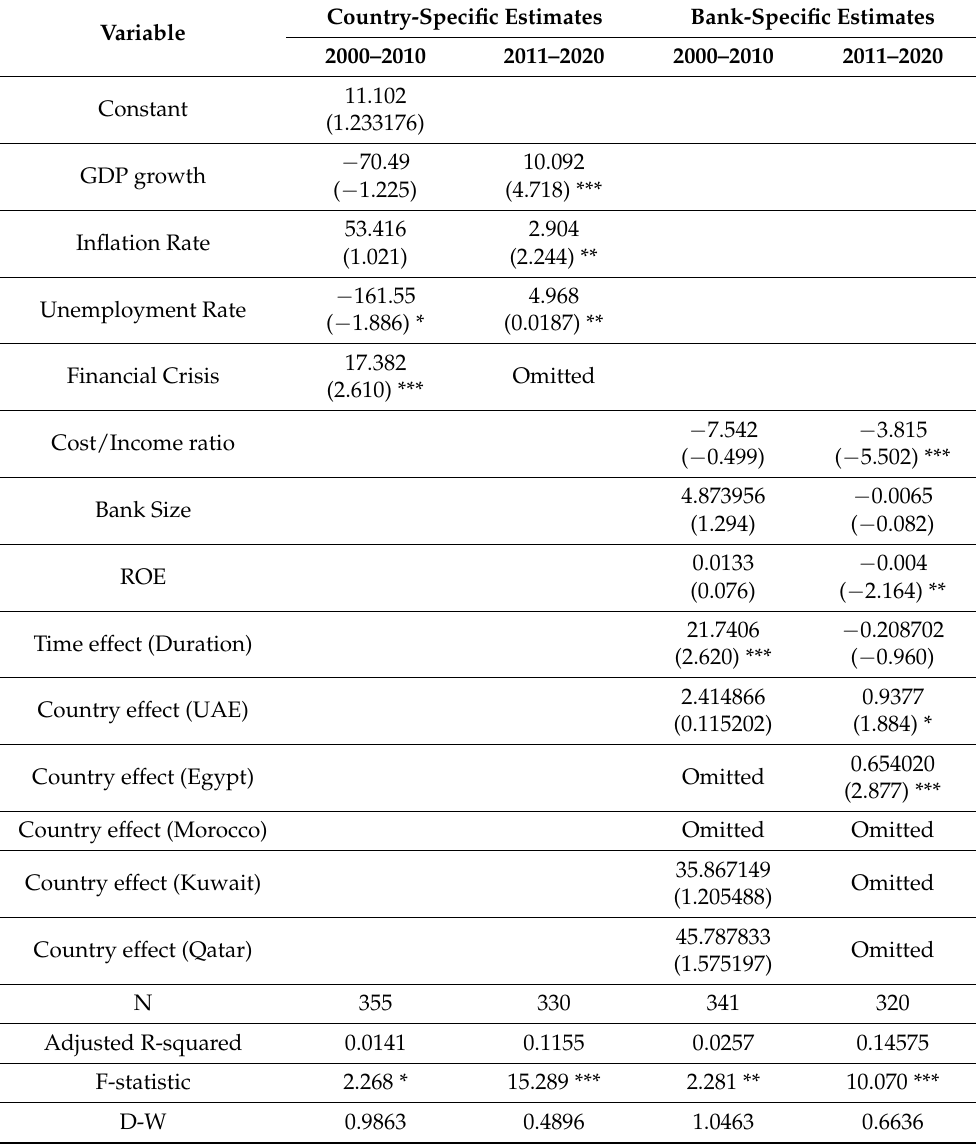
Table 4. The Robustness of the Stability of the Estimated Coefficients over